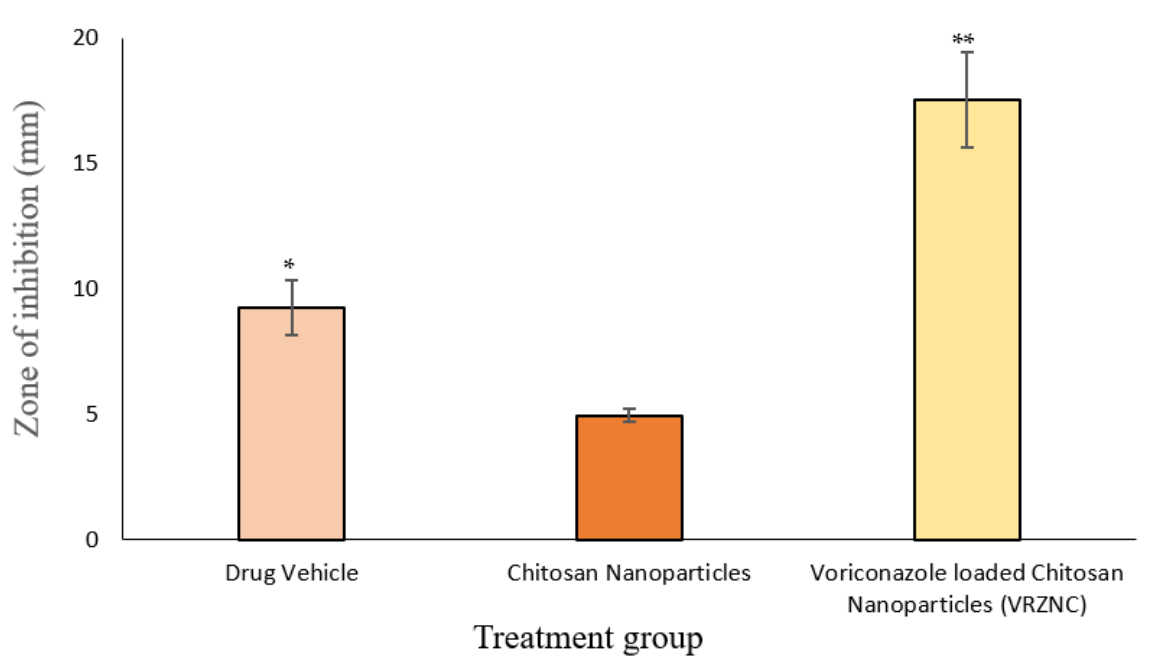
Figure 8. In vitro antifungal activity of drug vehicle, chitosan NPs, and voriconazole-loaded chitosan NPs against C. albi- cans : n = 3, mean ± S.D., * p < 0.05 and ** p < 0.001 considered statistically significant different from without drug-loaded chitosan